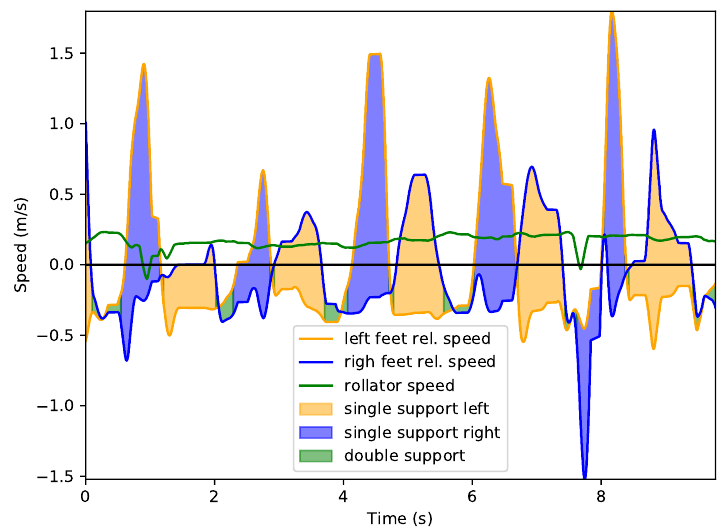
Figure 9. Leg motion speed relative to rollator for user 1.